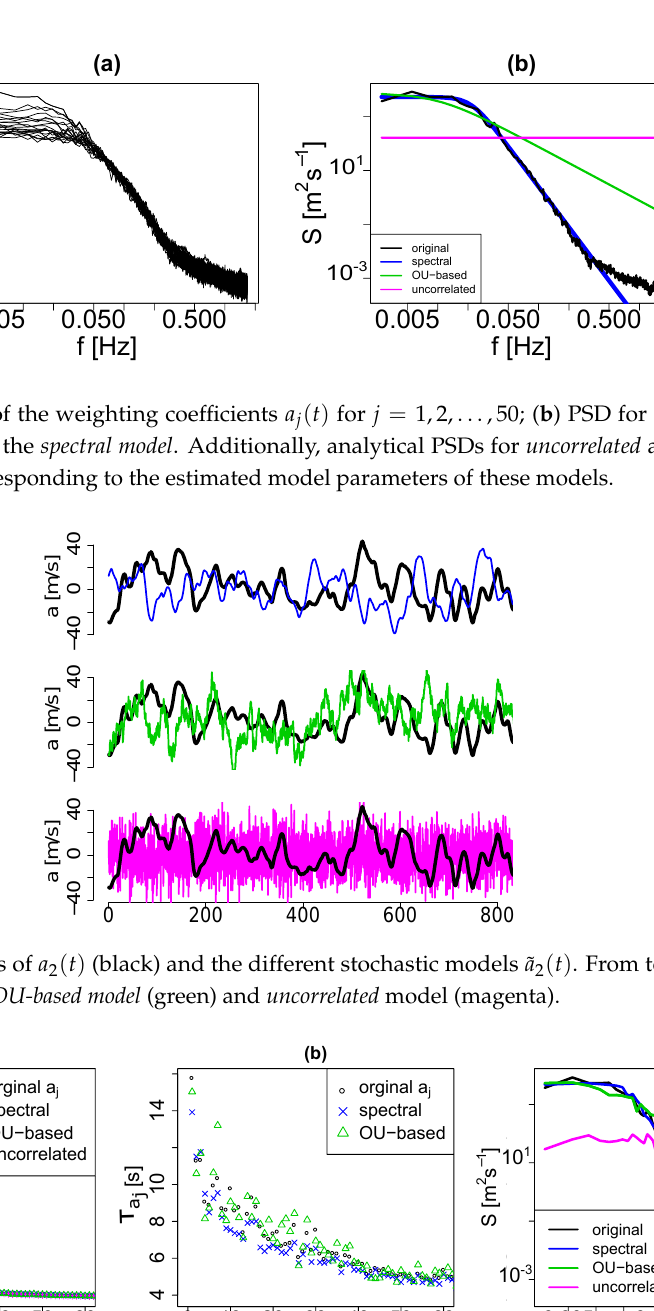
0 Figure 15. Properties of the weighting coefficients a j ( t ) and the stochastic models ˜ a j ( t ) : ( a ) Variance versus mode number j ; ( b ) Integral time scales versus mode number. The results for the uncorrelated model are not shown since the integral time scale is zero for all j ; ( c ) Estimated PSDs of a 2 ( t ) and realisations of the different stochastic models ˜ a 2 ( t )